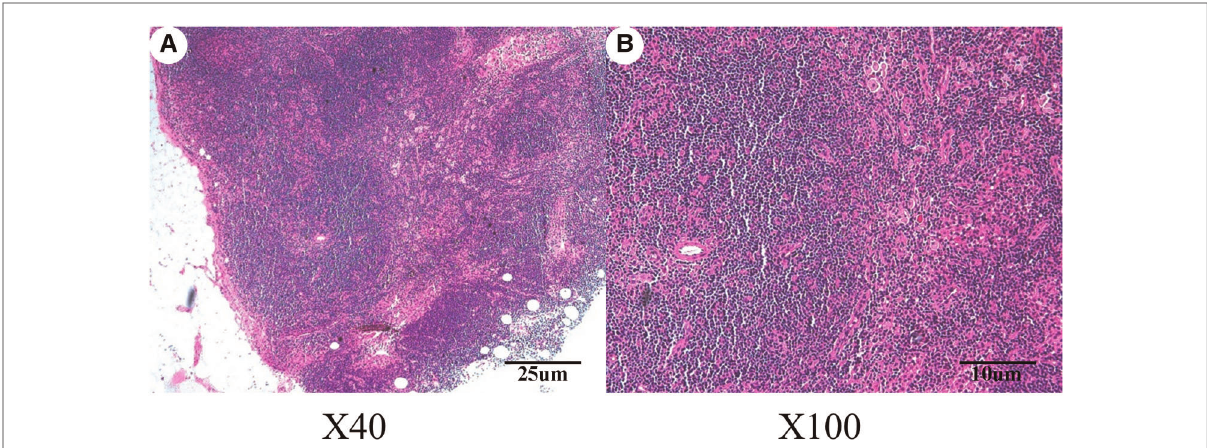
FIGURE 3 Hematoxylin – eosin staining revealed that no metastasis was observed in the sentinel lymph nodes of the right breast. ( A ) Magni fi cation of the main body of the lymph nodes (original magni fi cation ×40); ( B ) magni fi cation of the main body of the lymph nodes (original magni fi cation